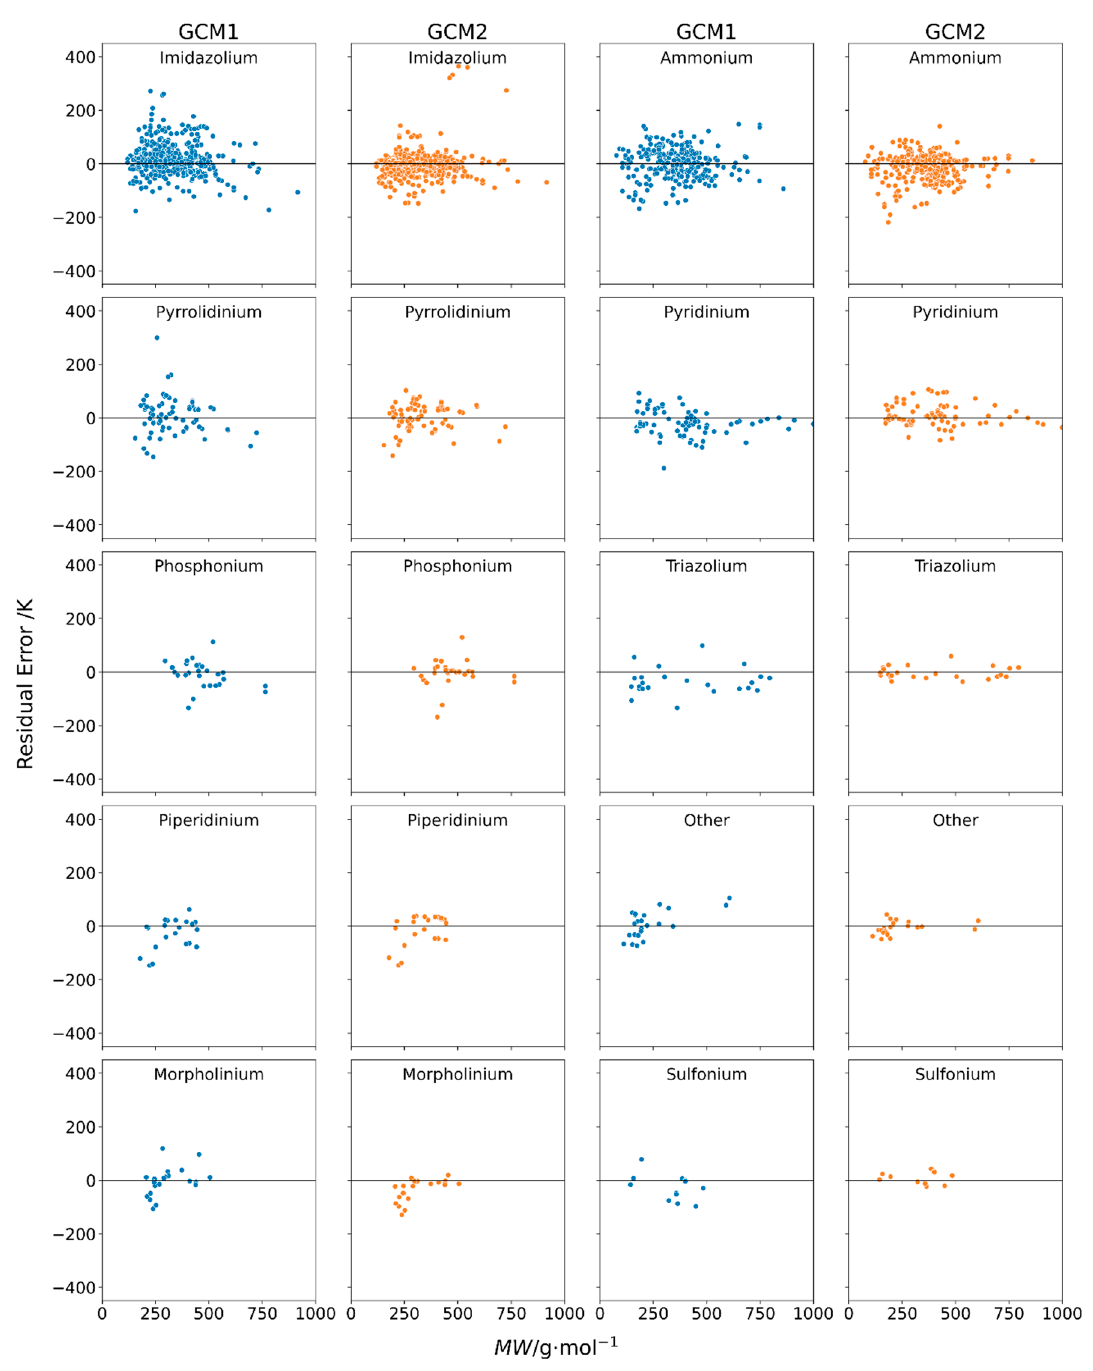
Figure 4. Individual residual plots of error versus molecular weight using GCM1 (blue) and GCM2 (orange) to estimate melting points for ILs containing several different cation types.